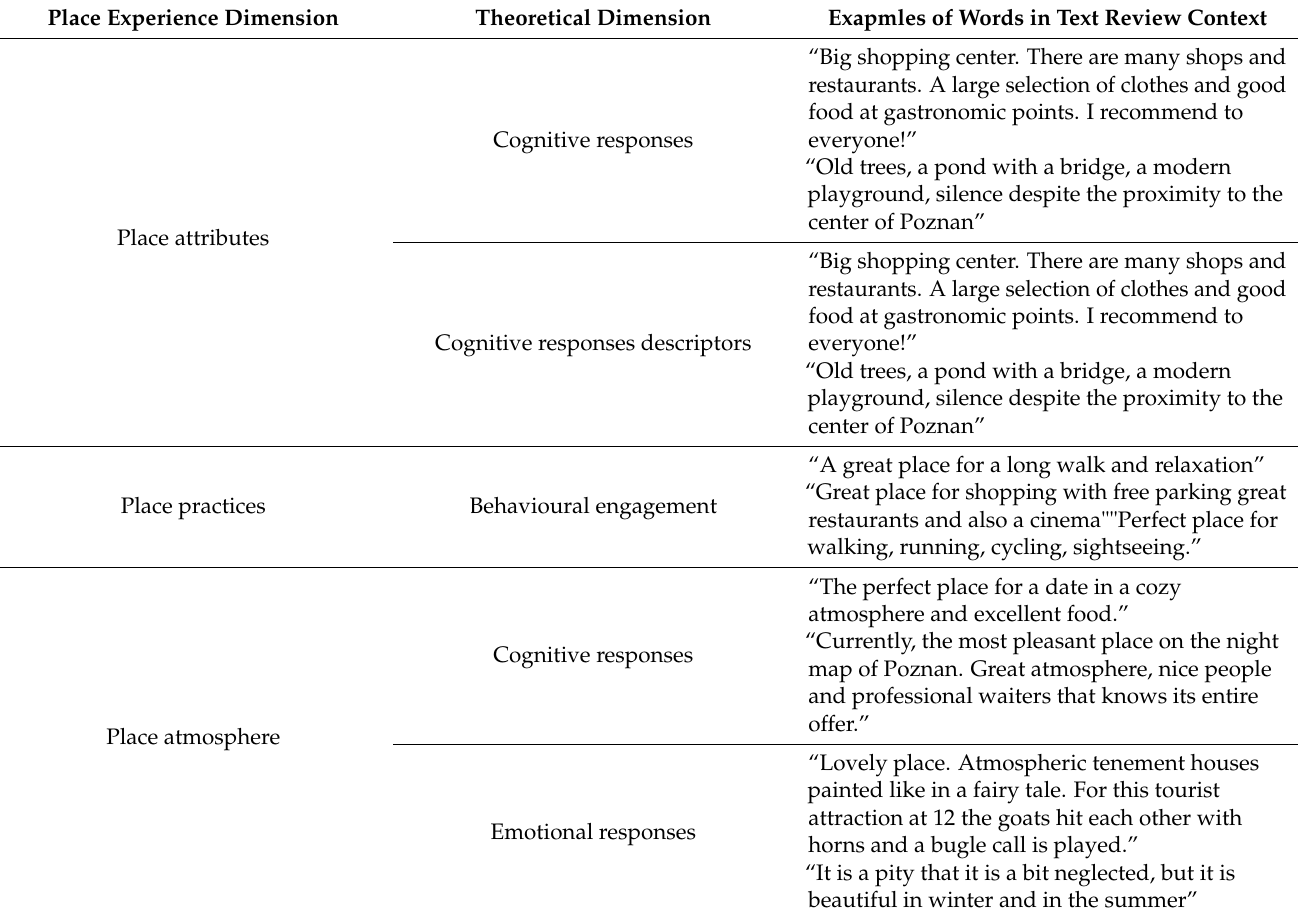
Table 3. High-frequency word coding in review context